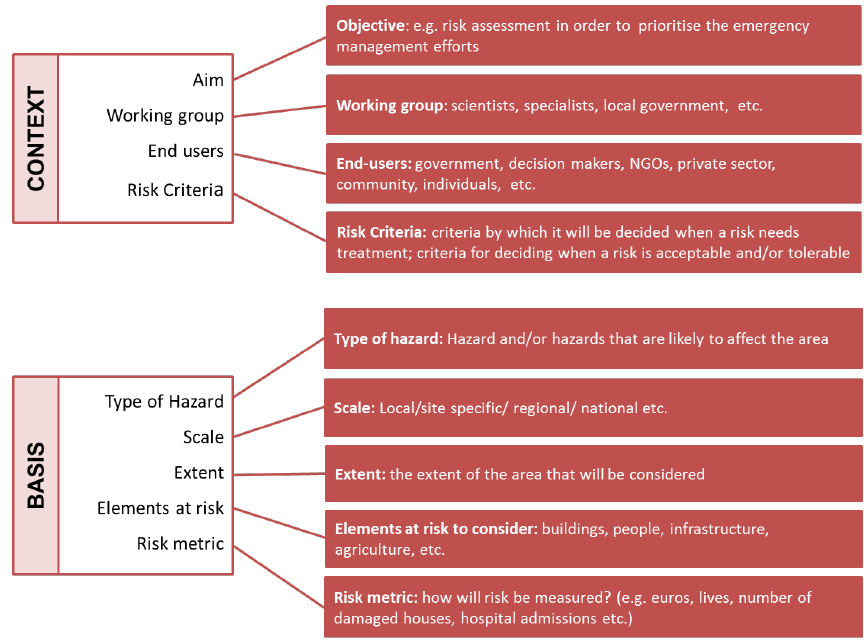
Figure 3. Detailed description of risk identification [46].